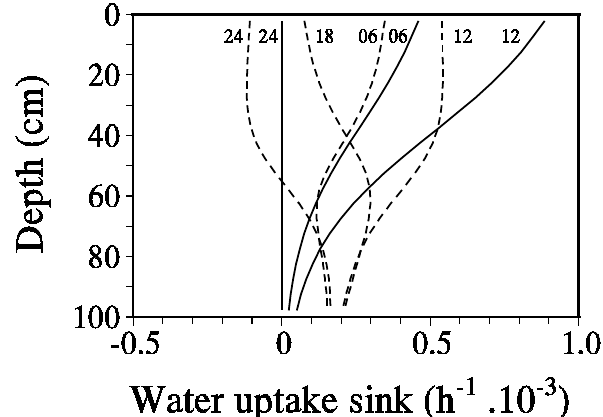
Fig. 4. Diurnal variations in the water uptake sink on day 10 of a 20-day dry-down period from saturation, simulated with equa- tions 1 to 4, assuming M 0 to be given by Eq. (8) (dashed lines) or Eq. (17) (solid lines), for the case of moderate compensation ( R L( eff ) = 10cm cm − 2 ) . Remaining parameter values are as given in Table 1, initial/boundary conditions in the